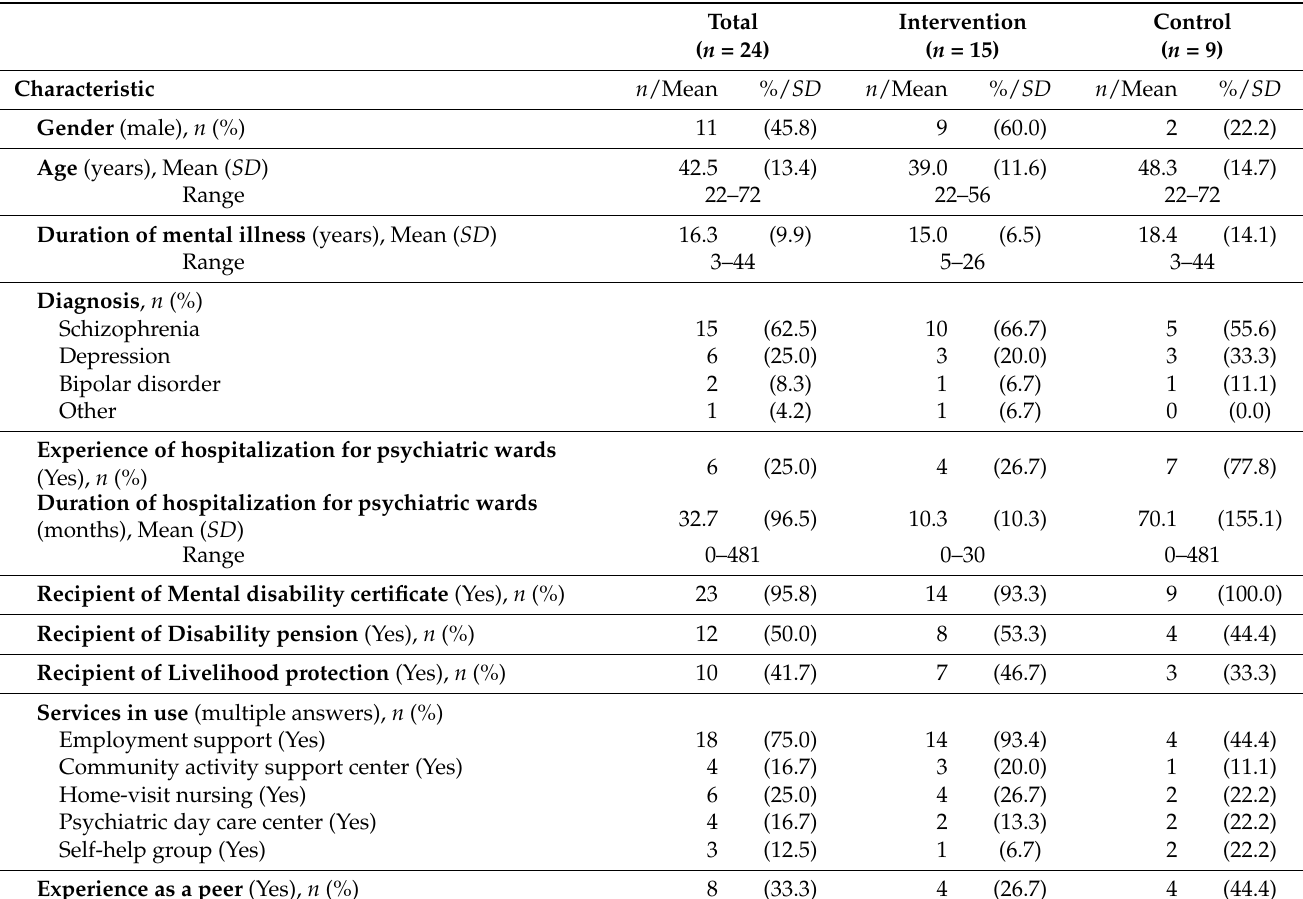
Table 1. Clinical and sociodemographic characteristics of the participants in the study ( n =